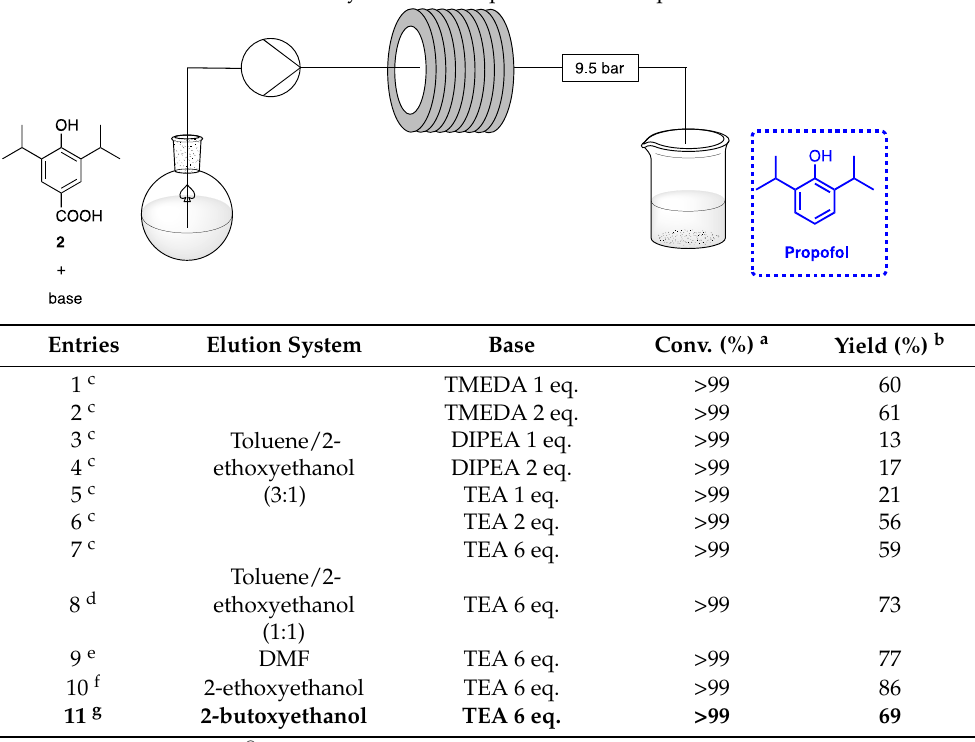
Table 2. Continuous flow decarboxylation of compound 2 into Propofol a .